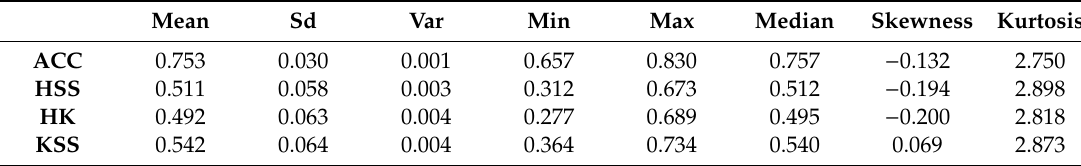
Table 5. Statistics for the scores of the K -nearest Neighbors (KNN) method ( K = 3).